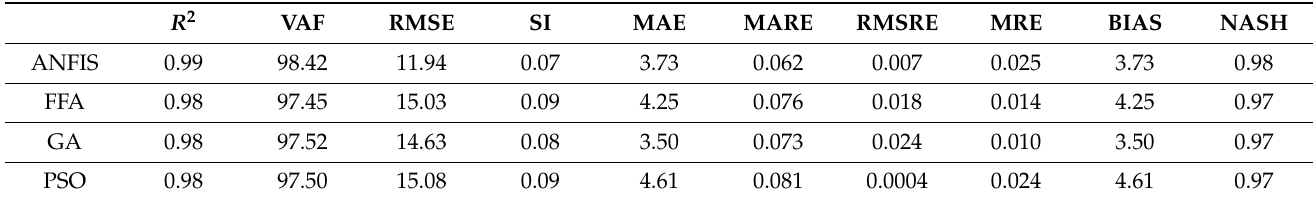
Table 5. Summary of model accuracy indicator test for test data set (for the second combination data set), which was calculated in Excel.